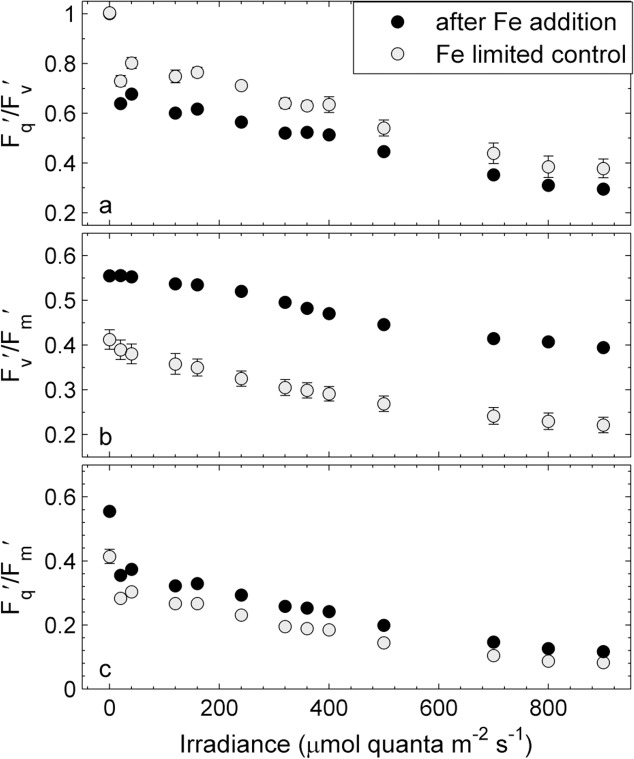
Light dependency of ChlF-derived parameters from FRRF measurements on day three after iron addition and in the iron-limited control treatment.The parameter Fq′/Fv′ (a) represents the efficiency of charge separation in functional RCII and is an estimate of the fraction of open RCII (i.e. QA oxidized) at any given light level. The parameter Fv′/Fm′ (b) represents the efficiency of excitation energy capture by the fraction of open RCII and can be used to quantify the extent to which non-photochemical quenching in the PSII antenna competes with photochemistry for excitation energy. The parameter Fq′/Fm′ (c) represents the overall quantum efficiency of photochemical energy conversion in PSII (Φ′PSII). See text for a full description of these parameters and their interpretation. Error bars represent standard errors from three biological replicates and are often smaller than symbols.